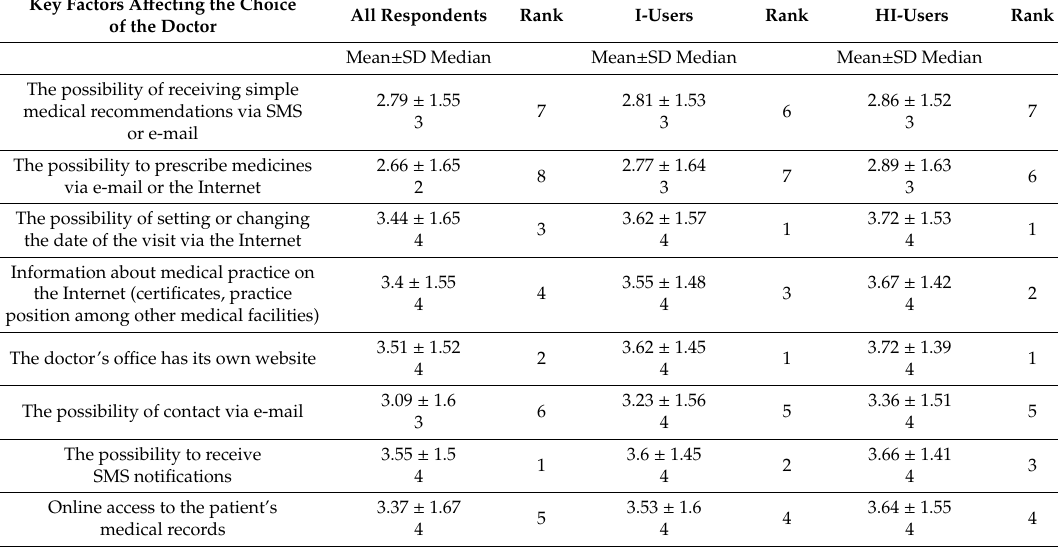
Table 2. Key factors a ff ecting the choice of the